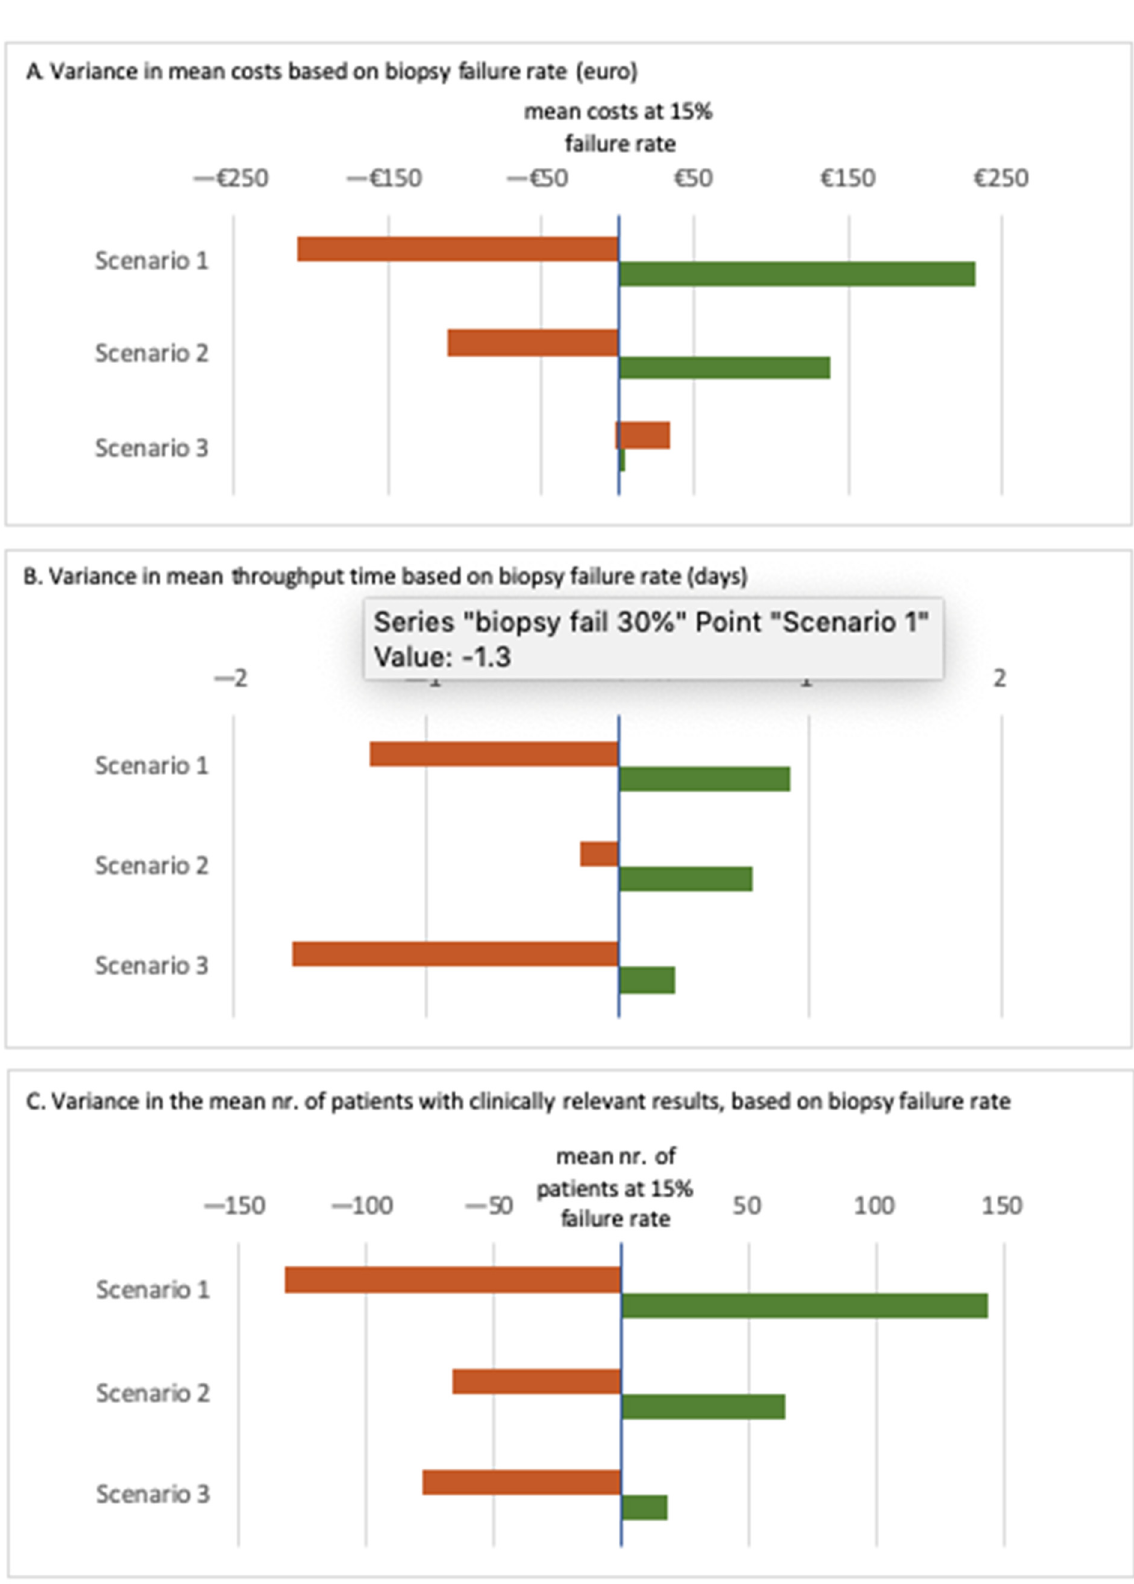
Figure 4. This figure shows the variance from the mean from the probabilistic sensitivity analysis (500 runs). The baseline point is ( A ) the mean of the costs for all patients with clinically relevant test results, ( B ) mean throughput time for all patients with clinically relevant test results, and ( C ) the mean number of patients with clinically relevant test results, with a tissue failure rate of 15%. The shown effect is for a tissue failure rate of 1% (green) to 30% (orange).